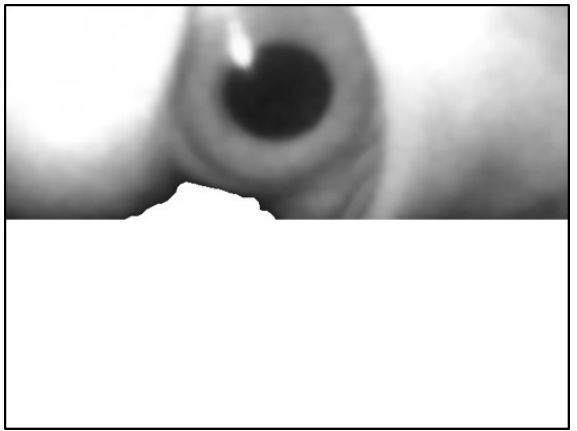
Figure 24. Filling the image in the lower part of the image.